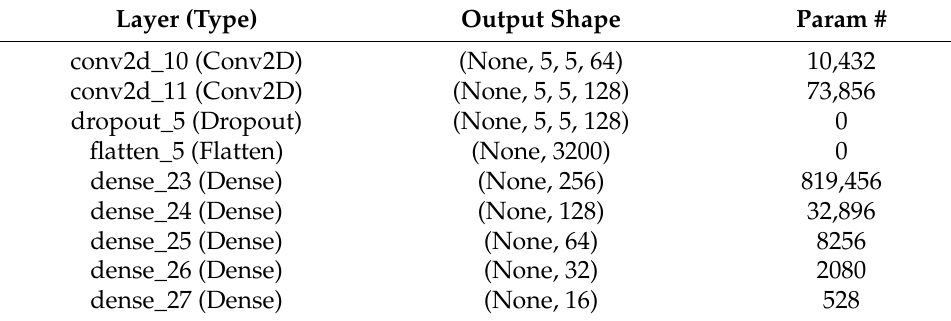
Table 4. CNN Model used for Indian Pines data.